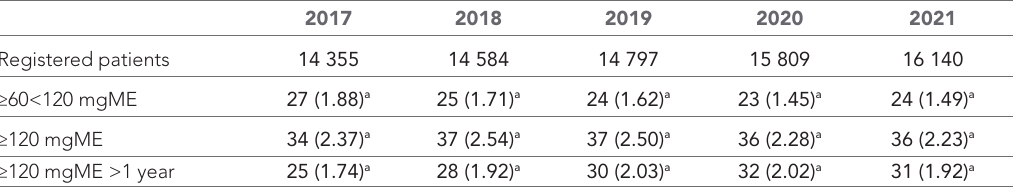
Table 3 Longitudinal high- dose prescribing data from Practice